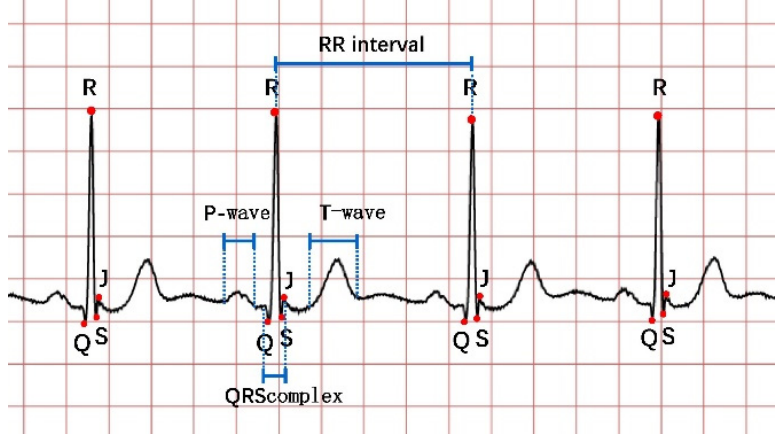
Figure 1. Schematic diagram of the electrocardiogram.